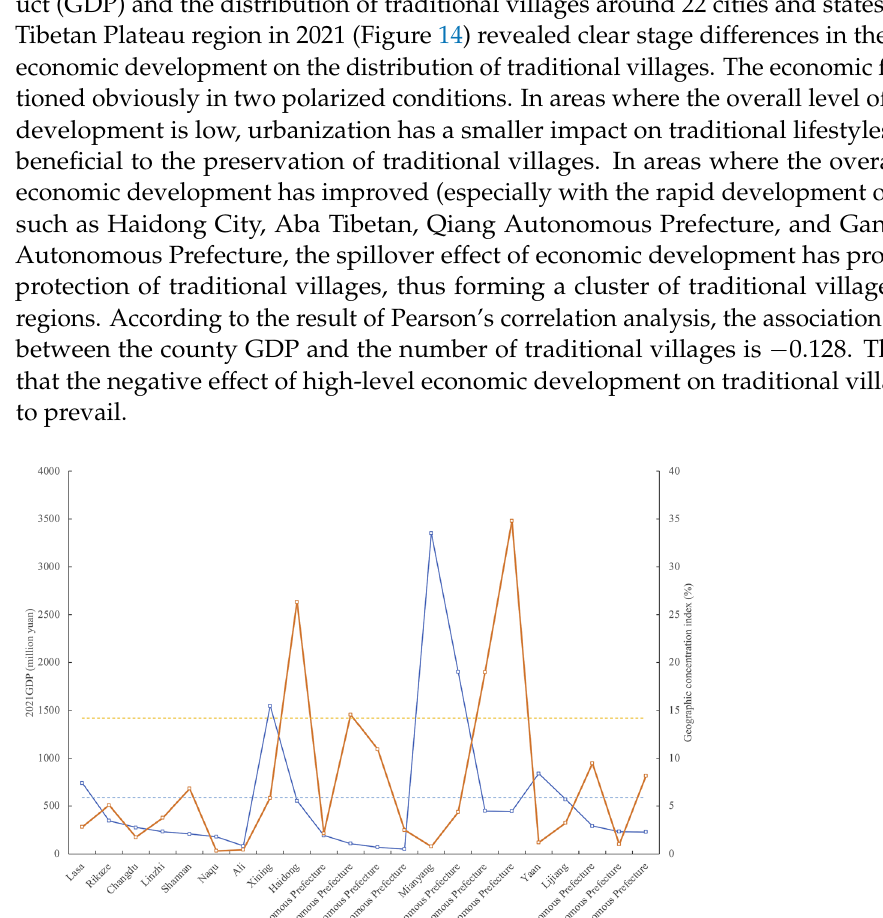
Figure 13. Distribution of traditional villages coupled with transportation systems on the Tibetan Plateau: ( a ) the spatial overlay analysis of village distribution and transportation systems; ( b ) the statistics of traditional villages in different transportation buffers.